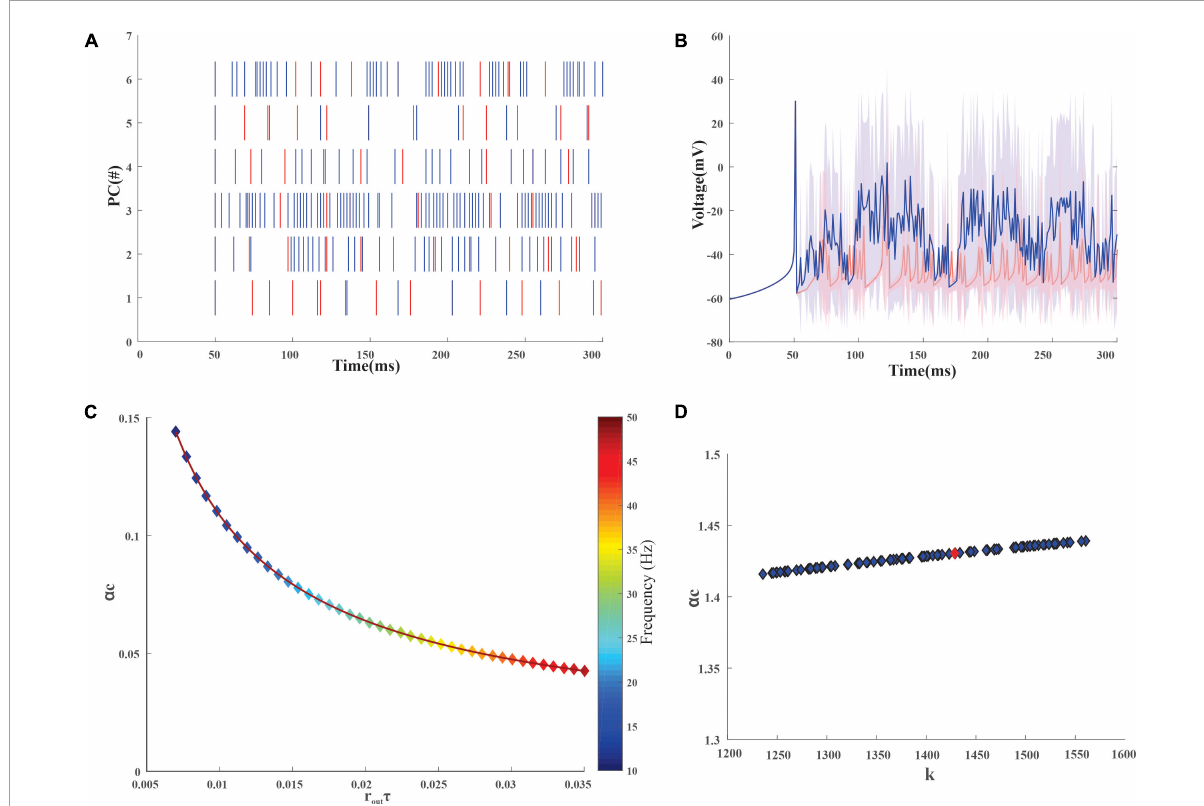
FIGURE5 Firing dynamics and quantification of stored input-output association in the Purkinje layer neurons. (A) Spike variability of the 6 Purkinje neurons in the network, pre (red) and post (blue) learning. As learning adaptation improves, the firing frequency of the PC was also observed to increase. (B) Superimposition of the average firing dynamics of PC (pre and post) showed an increase in the firing frequency after learning adaptation with an increase in standard deviation (C) . Storage capacity ( α c ) of PC with a firing frequency of 30–500 Hz was calculated and as mean firing output spike time (r out τ ) increases, the storage capacity decreases gradually (D) . Storage capacity ( α c ) of PC with stability constant ( κ ) representing the storage of new patterns at the synapse. Purkinje neuron (red dot) with a membrane time constant ( τ m ) of 64 ± 17 ms was used for the reconstruction of the